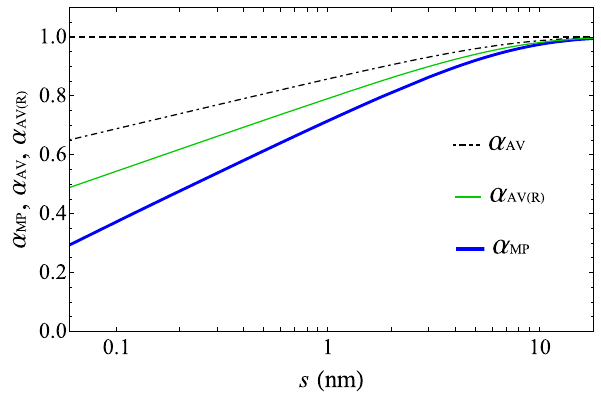
Fig. 3 Dependenceoftherelativevalueof E MP (thicksolidline), E AV (dot-dashed line) and E AV ( R ) (thin solid line) on separation between the electron and positron in a silicon target of 16 µ m thickness; α AV is estimated for the pair energy of E = 1